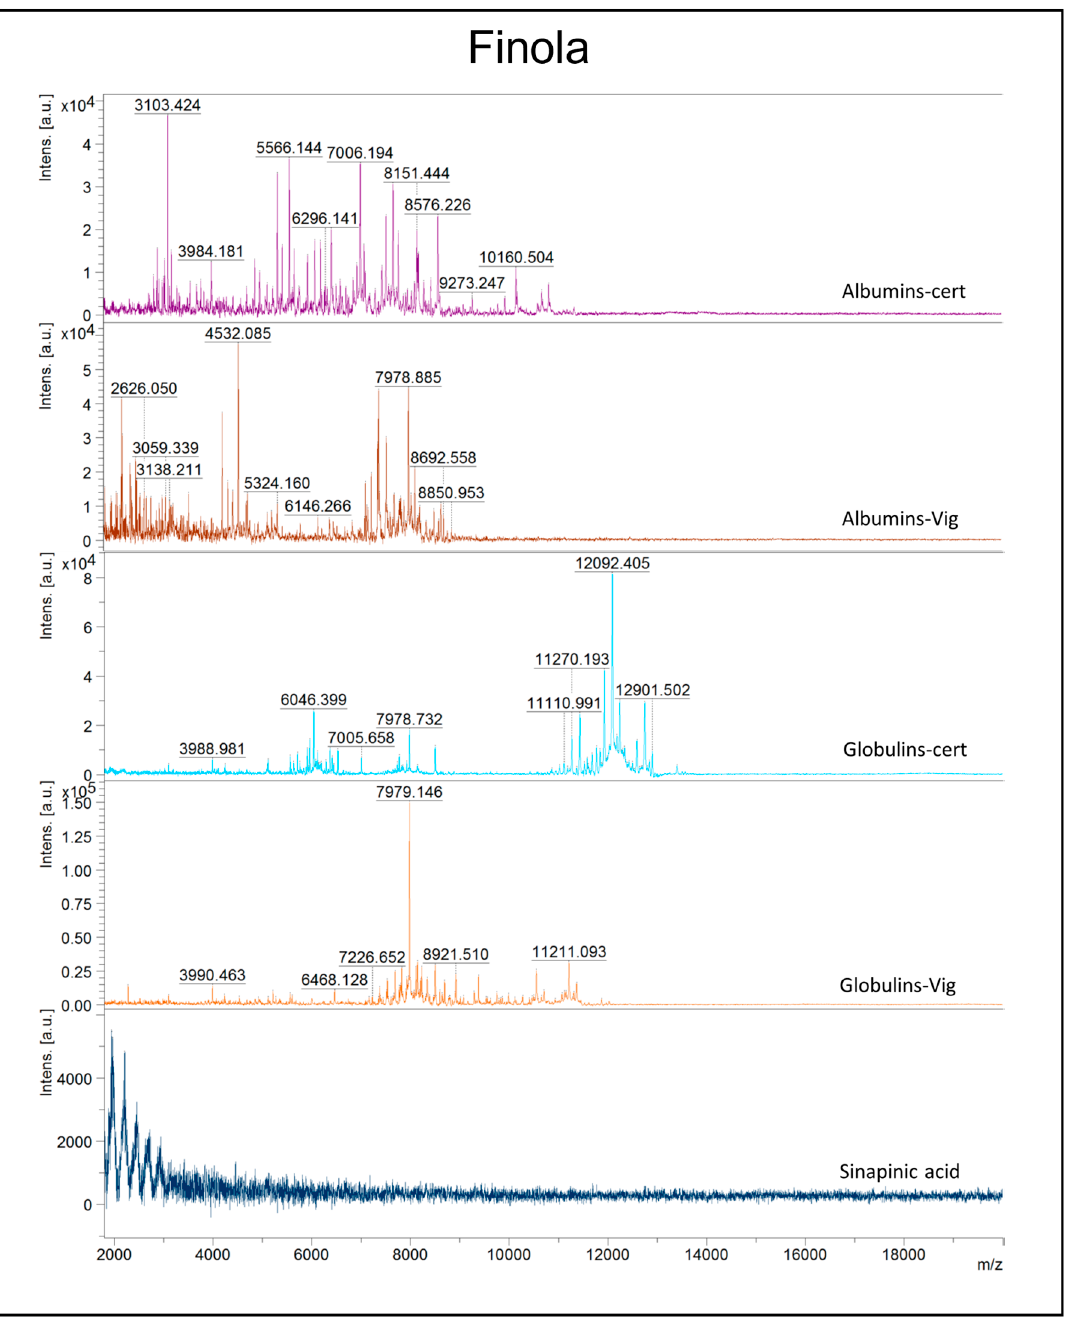
Figure 3. Representative MALDI-TOF MS mass spectra in the m/z region 2000–20,000 for protein extracts (albumins/globulins) of Finola seeds from commercial source (cert) or experimental field (Vig). The mass spectrum of the matrix (sinapinic acid) is also presented as reference. The most intense signal for globulin extracts of certified seeds was detected at 12,092 m/z, while it was absent in seed extracts from the experimental